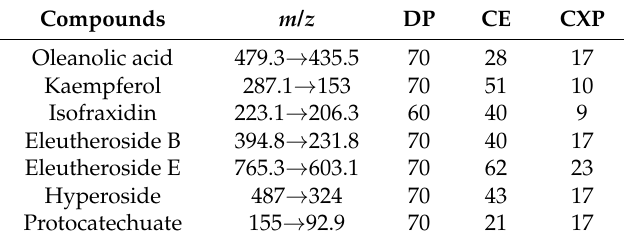
Table 1. Transitions, cluster voltage, collision voltage and chamber injection voltage of seven